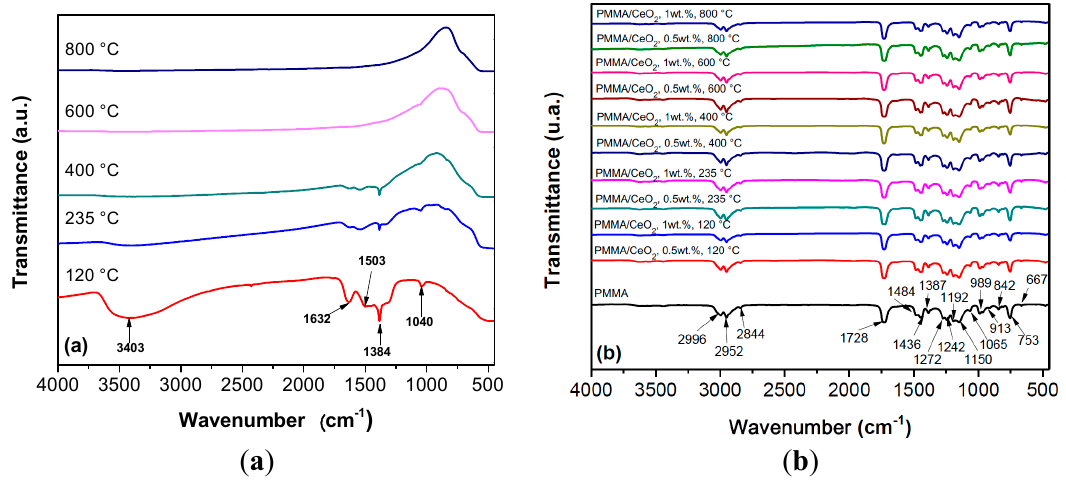
Figure 1. FT-IR spectra of ( a ) CeO 2 thermally treated at different temperatures and ( b ) pure PMMA and PMMA/CeO 2 hybrid systems.